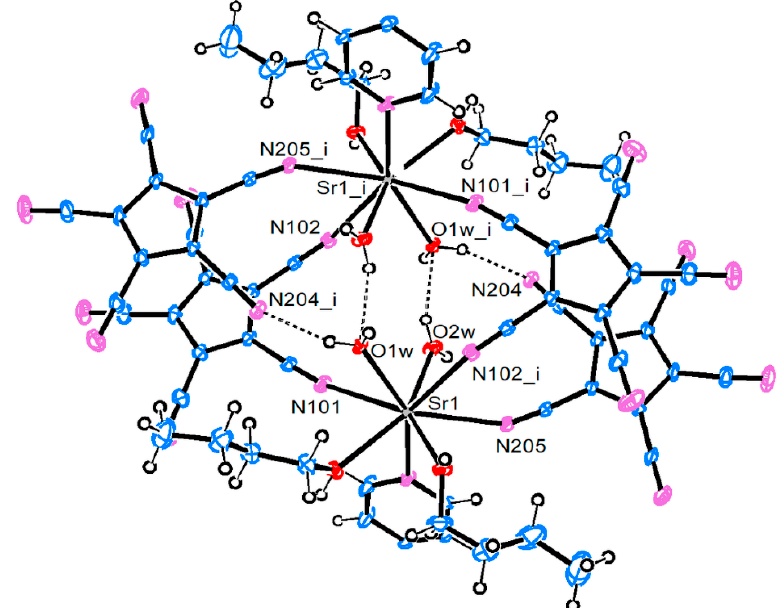
Figure 16. The dimeric quadruply anion-bridged subunit of compound 4 . Symmetry operator: i: − x , − y , 1 − z.